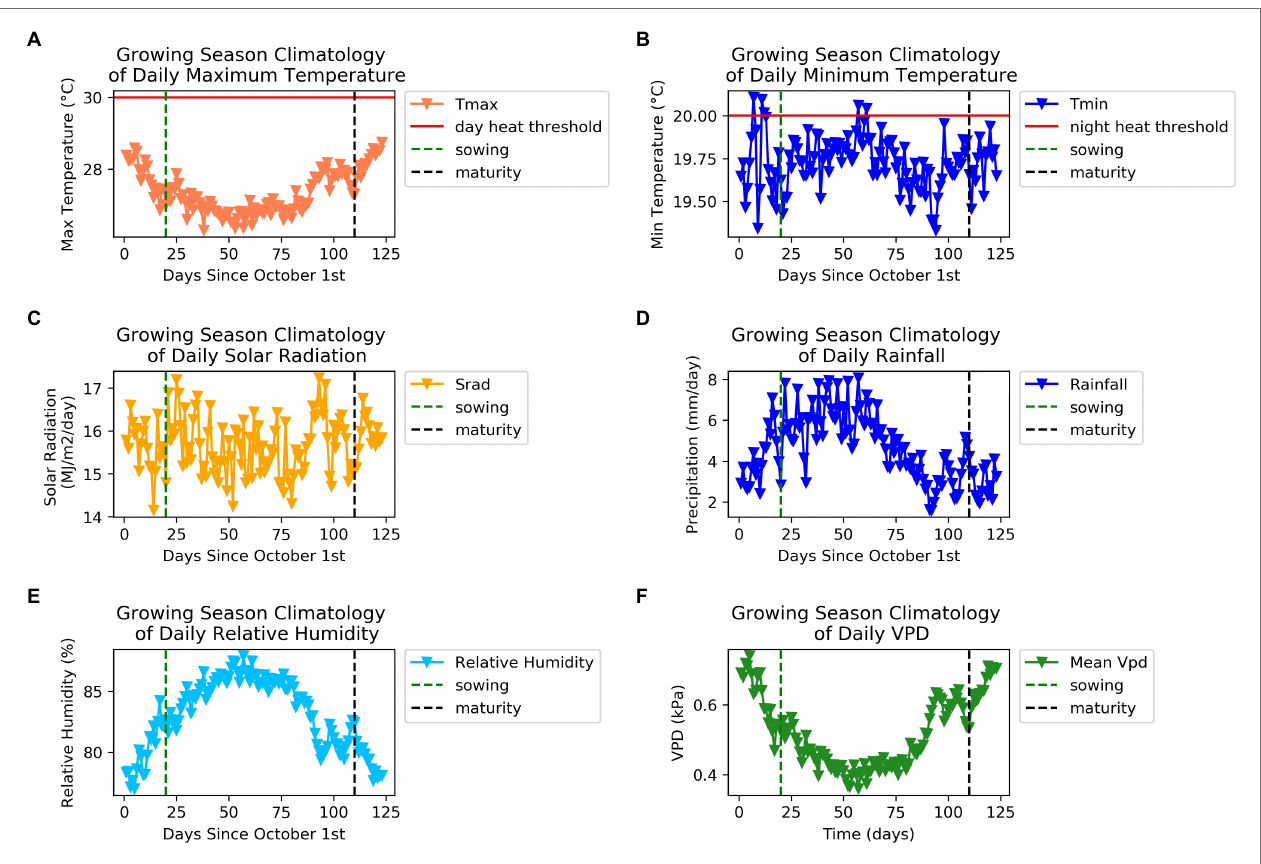
FIGURE 2 | Weather characteristics of the main growing season in Florencia for the years 1984–2014 (A) Daily maximum temperature ( ° C), (B) daily minimum temperature